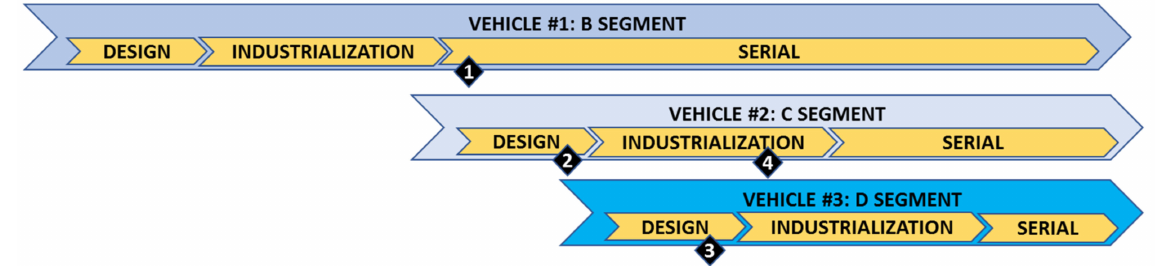
Figure 8. First applications of methodology in different vehicles, segments, and stages.